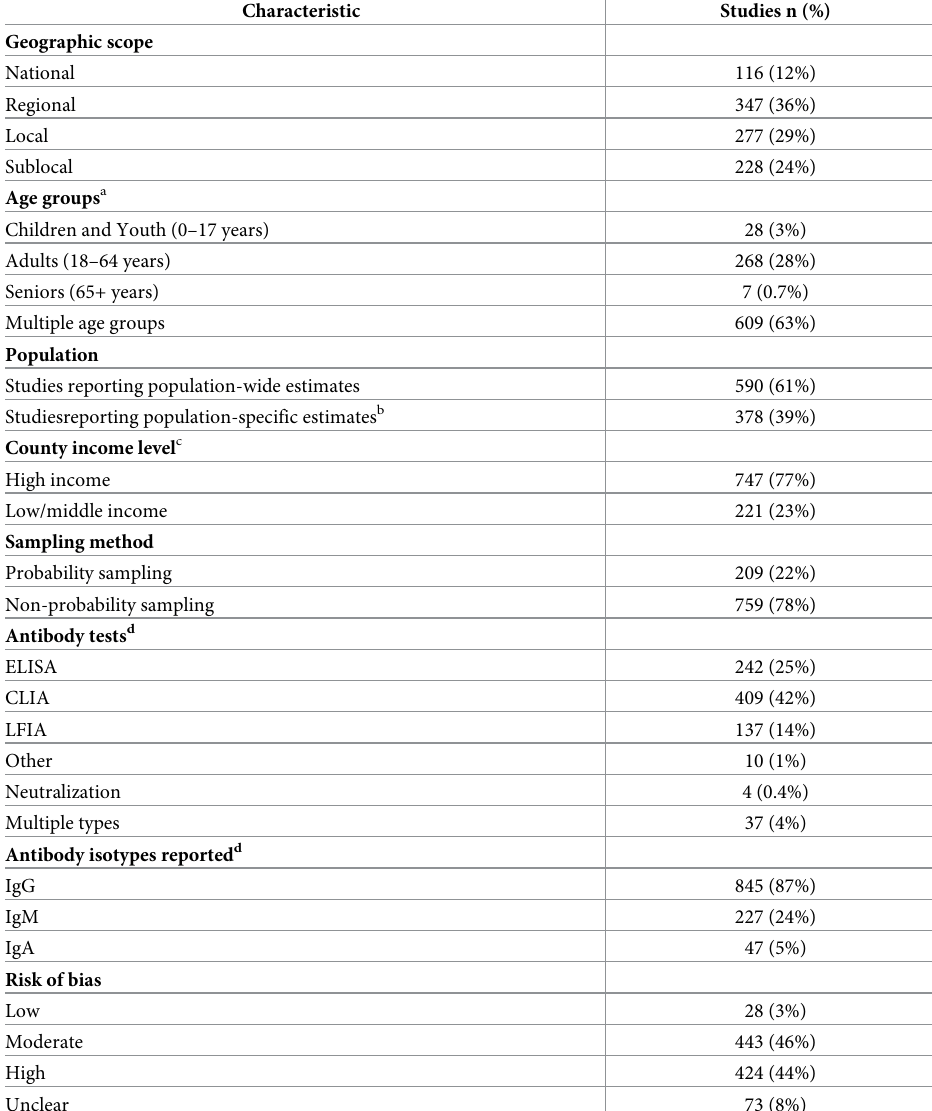
Table 1. Summary characteristics of included